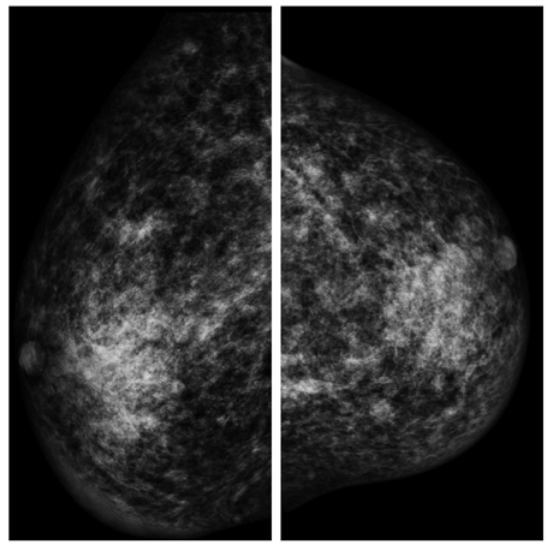
Figure 2. Mammography findings (left and right breast).